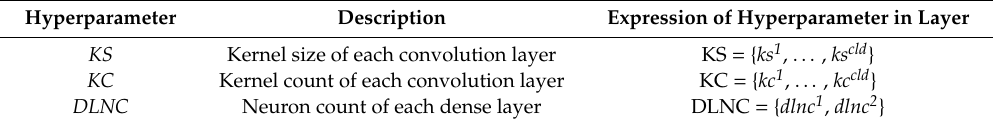
Table 4. Hyperparameters to be optimized for 1D